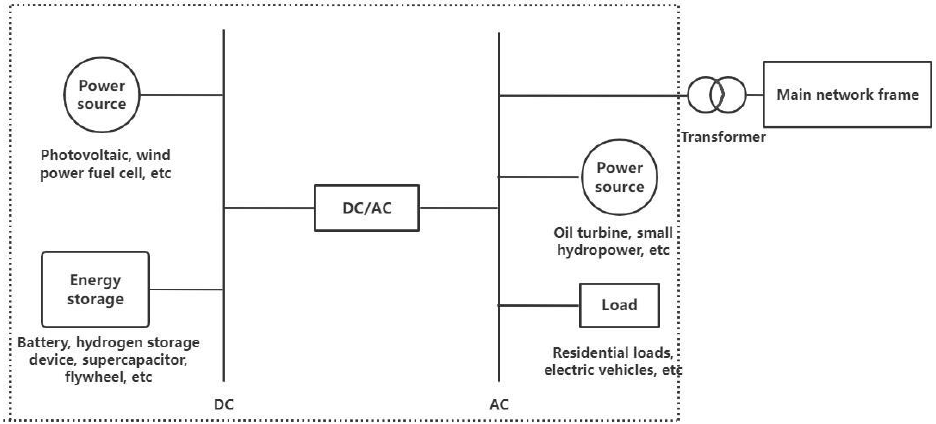
Figure 1. Framework of energy management system in microgrid.